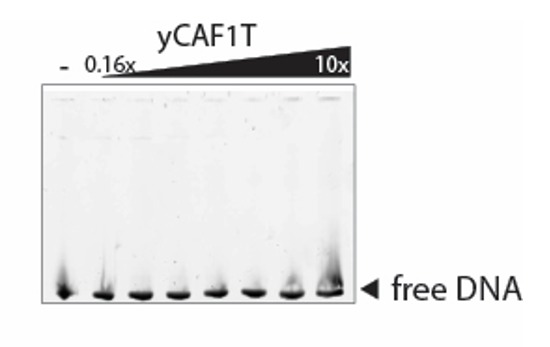
DOI:
http://dx.doi.org/10.7554/eLife.23474.024